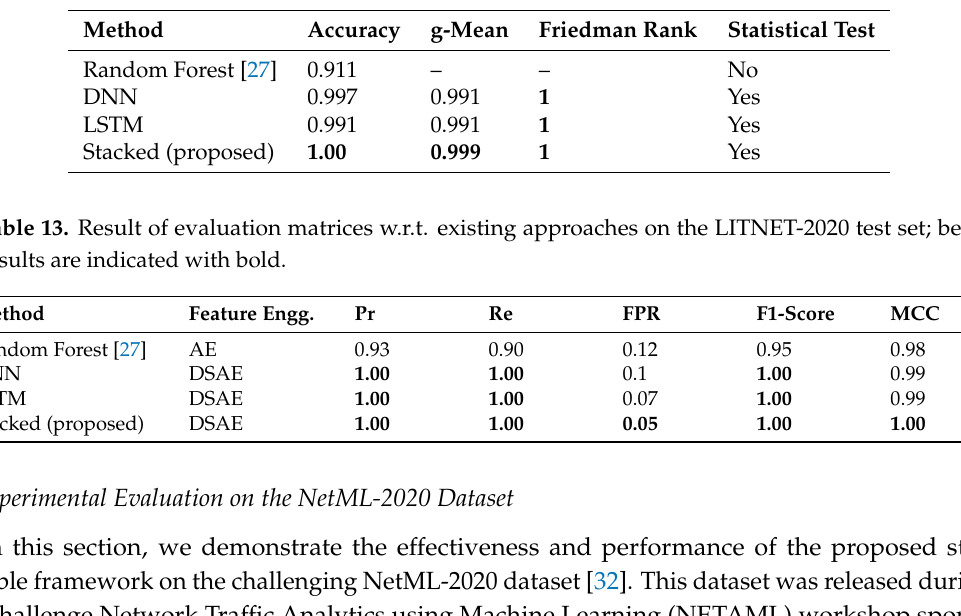
Table 12. Performance evaluation of the LITNET-2020 test set; best results are indicated with bold.